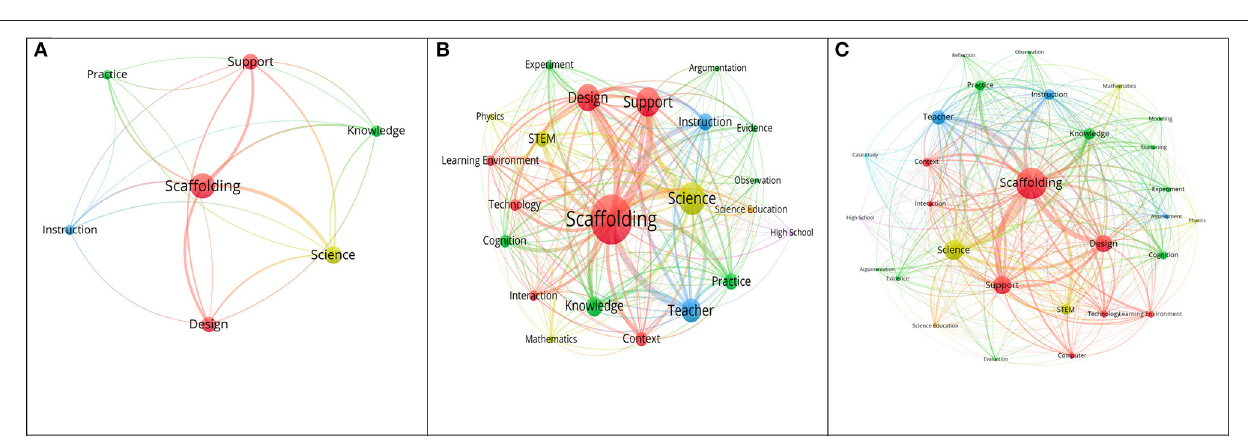
support, teacher, instruction, science, and elementary school ( Figure 7A ). Researchers who aimed at scaffolding elementary school learners may specifically tend to address the role